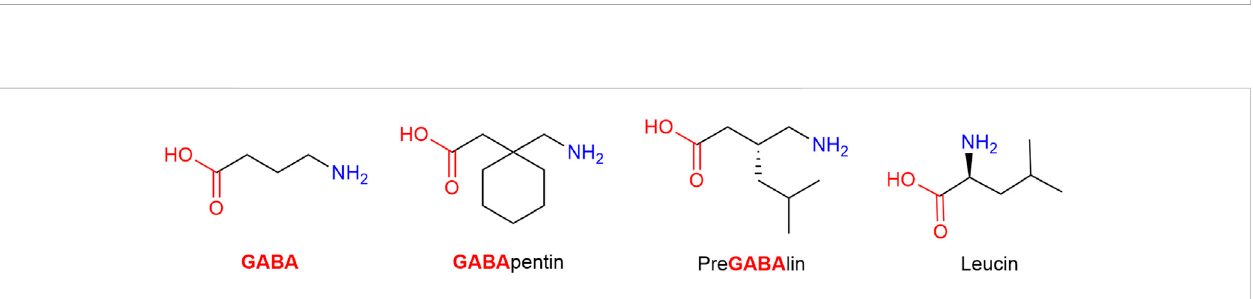
Frontiers in Cell and Developmental